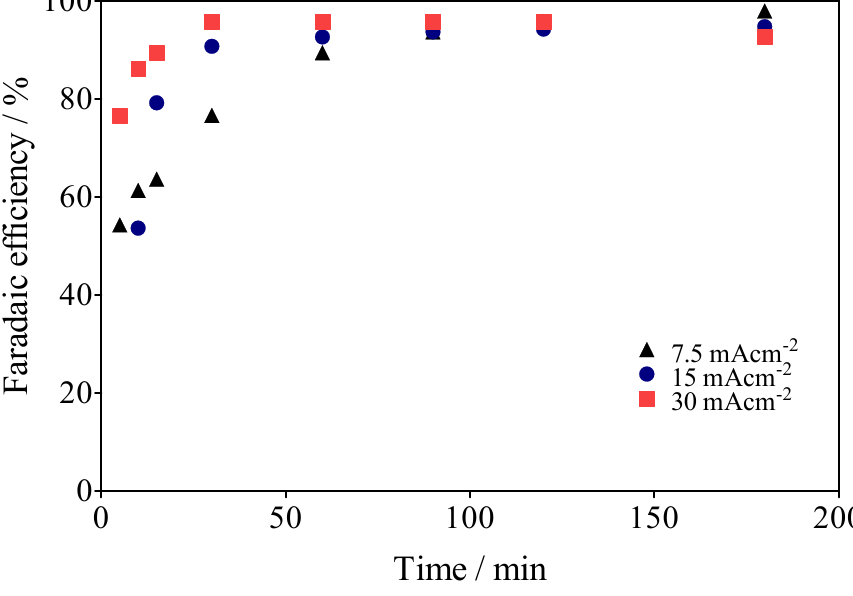
application of remote devices in areas of high solar irradiation resource